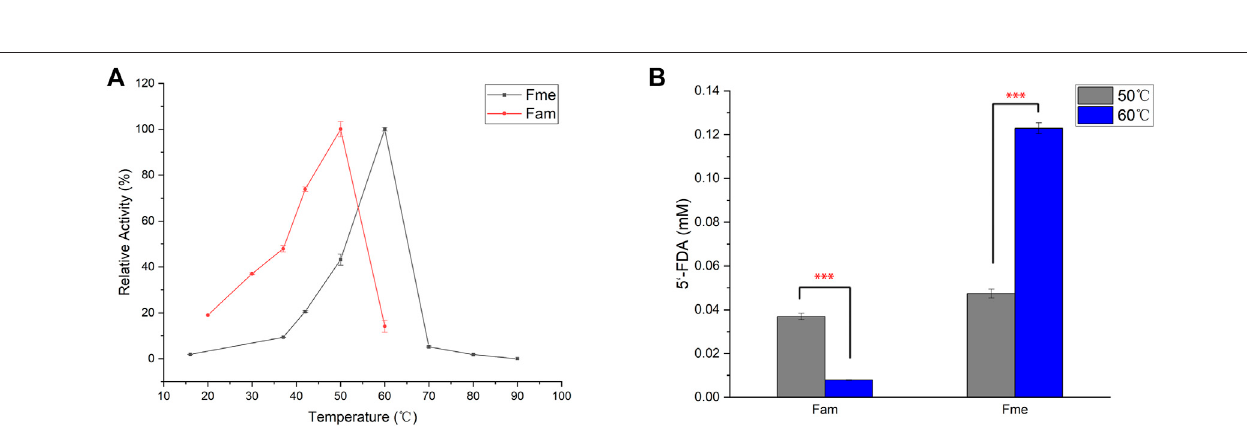
FIGURE 3 | In fl uence of temperature on fl uorinase. (A) Effect of temperature on fl uorinase activity. Assays were carried out in Tris-HCl buffer (50 mM, pH 7.8), containingKF(100 mM),SAM(400 µM),and enzyme(60 μ g/ml)for1 h (B) Effectoftemperature on5 ′ -FDAyield. Theassayswerecarried outwithTris-HCl(50 mM, pH 7.8), containing 200 mM KF, 1 mM SAM and 50 μ g/ml pure enzyme for 0.5 h. Error bars represent the standard deviation obtained from three replicates. *** p <